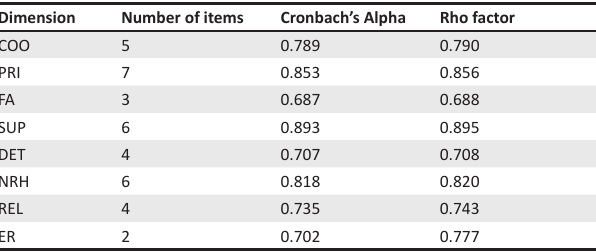
TABLE 6: Reliability estimates ( n = 789). Dimension Number of items Cronbach’s Alpha